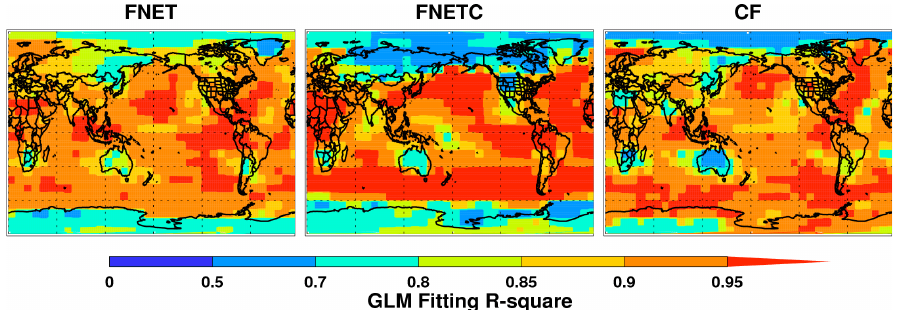
Figure 7 Spatial distributions of R 2 of the GLM models for FNET, FNETC, and CF. 1074 Fig. 7. Spatial distributions of R 2 of the GLM models for FNET, FNETC, and CF.